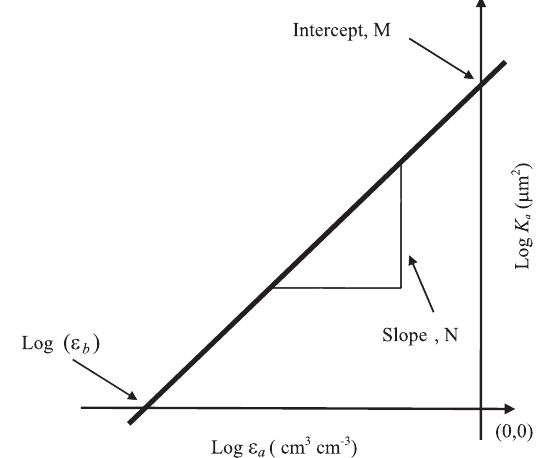
Figura 1. Principais características da relação log (conteúdo volumétrico de ar, εεεεε ) – log a (permeabilidade ao ar - K ); inclinação da reta, a N ; intercepto com o eixo log ( K ), M ; e o limite do a conteúdo de ar, εεεεε b